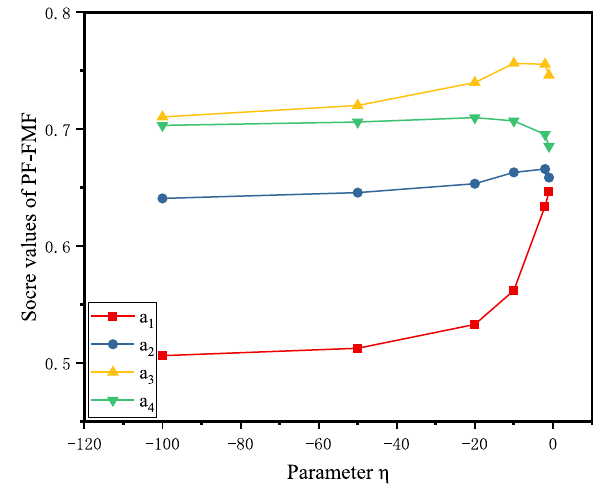
Fig. 6 Score values of the alternative using PF-FMF for different η